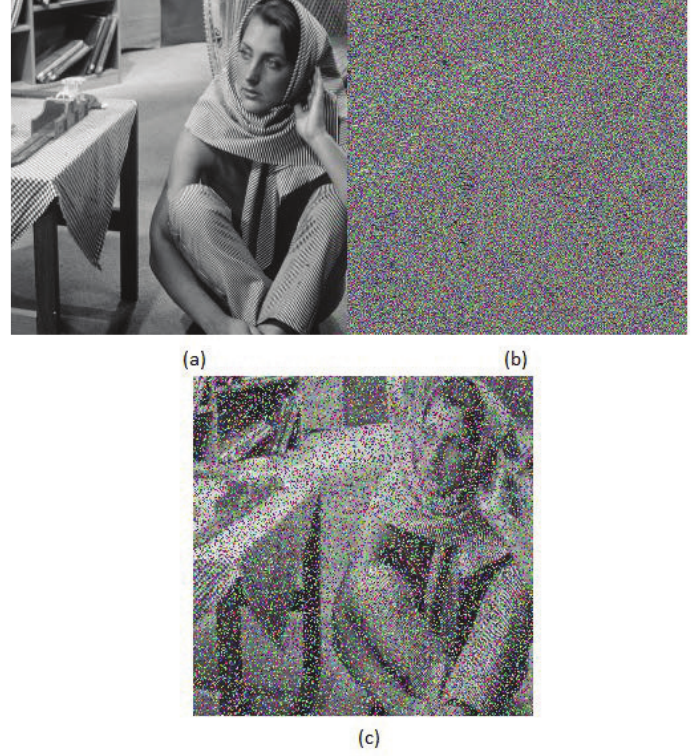
Figure 4. Flat image of Barbara ( a ). Decrypted image of Barbara when a multiplicative noise of size 40% is applied to a figure encrypted with AES–CBC ( b ). Decrypted image of Barbara when a multiplicative noise of size 40% is applied to a figure encrypted with ICLEBF ( c ).